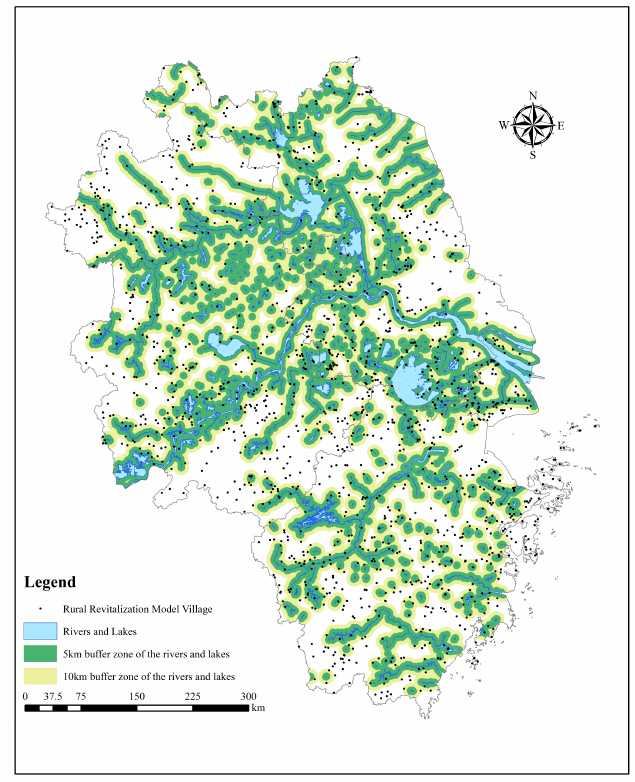
Figure 6. Water system buffer zones and rural revitalization model villages in the YRD.